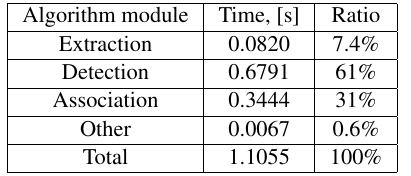
Table 3: Breakdown of the algorithm execution time for a typical